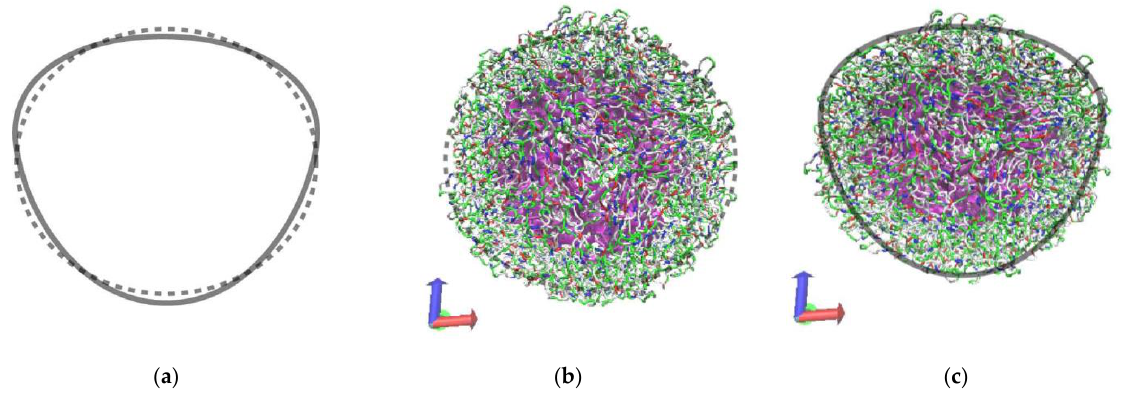
Figure 2. Output from VMD visualization software for the shockwave with initial water velocities of 99.999 Å /ps showing: ( a ) Illustration of cross-sectional shape of L3 spheroidal mode at maximum deformation (solid line), compared to initial spherical shape (dashed line) ( b ) The virus in its equilibrated state (time = 0.0 ps) — before encountering the shockwave, with spherical cross-section overlaid (dashed line) ( c ) The virus in the maximum compression state (time = 1.4 ps), corresponding to the first peak in the RMSD value, with cross-section of L3 mode of a sphere at maximum deformation overlaid (solid line). The color scheme shows the different types of molecules — the purple molecules are the nucleic acid of the core while the green molecules are the protein capsid.